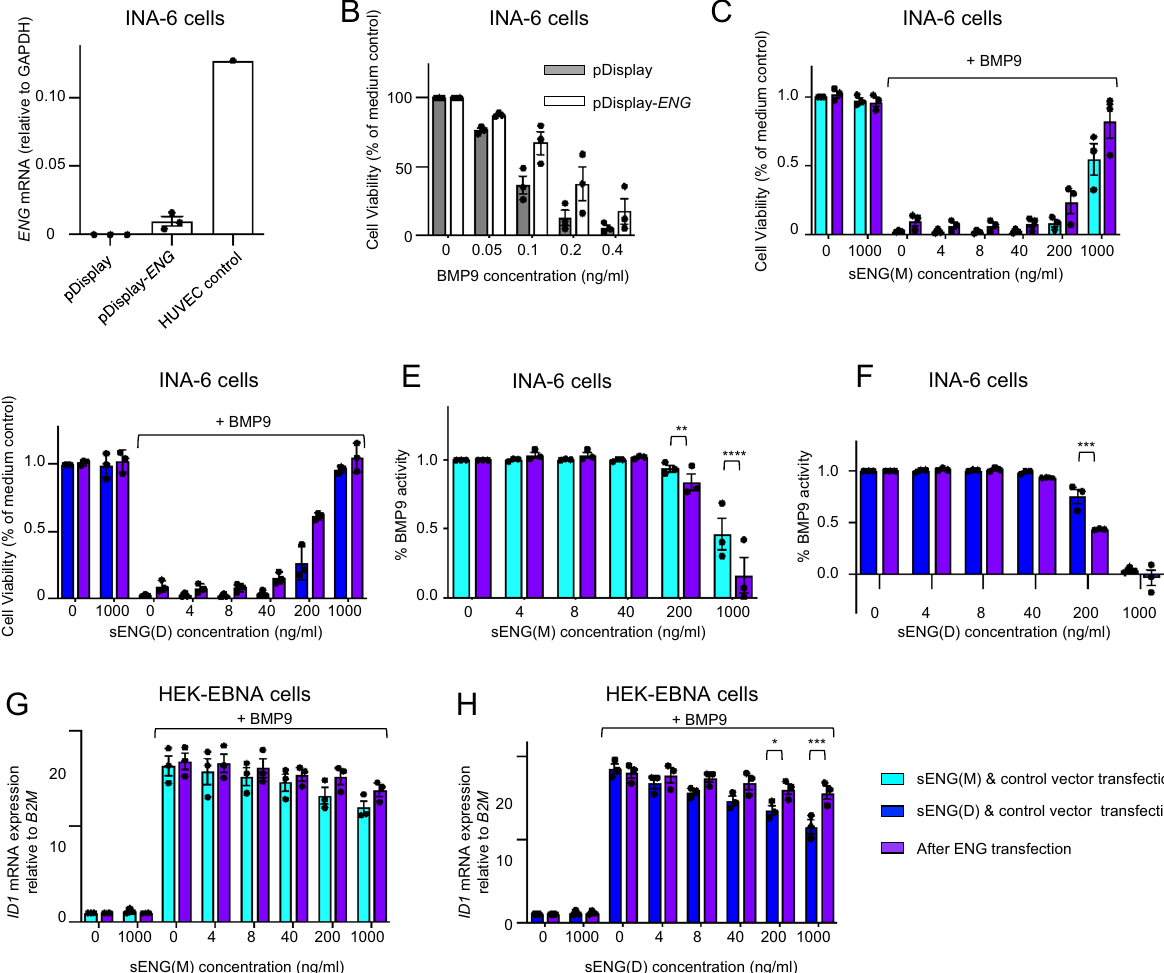
Figure 4. Effect of ENG transfection on BMP9 signaling in the presence or absence of sENG. ( A – F ) ENG in stably transfected myeloma cells inhibits BMP9-induced cell death and signaling. ( A ) ENG mRNA levels were measured by RT-qPCR in INA-6 cells stably transfected with pDisplay vector control or pDisplay-ENG; ( B ) Cells stably transfected with pDisplay and pDisplay-ENG were treated with increasing doses of BMP9. Cell viability was measured after 72 h using CellTiter Glo ATP assay and plotted as % of medium-treated control. (C – F) INA-6 cells stably transfected with pDisplay or pDisplay-ENG were treated with BMP9 (0.5 ng/mL) with increasing doses of sENG(M) (C & E ) or sENG(D) ( D & F ). The cell viability relative to medium control (C & D ) and the calculated % BMP9 activity compared to cells treated with BMP9 only ( E & F ) are shown. % BMP9 activity is calculated as described in Fig. 1B. ( G & H ) Effect of sENG on BMP9-induced ID1 gene induction in HEK EBNA cells with or without ENG transfection. HEK EBNA cells transfected with vector control or pDisplay-ENG were treated with 3 ng/ml BMP9 for 1.5 h in the presence or absence of sENG(M) or sENG(D) at indicated concentrations. Cells were then harvested for RNA extraction. Relative changes in ID1 gene expression were measured by RT-qPCR using the ∆∆CT methods. Three independent transfection experiments were performed, and data shown as Mean ± SEM. For E to I , Two-way ANOVA comparing sENG effect on BMP9 signaling in receptor-transfected and vector control-transfected cells, * P < 0.05, ** P < 0.01, *** P < 0.001, **** P <